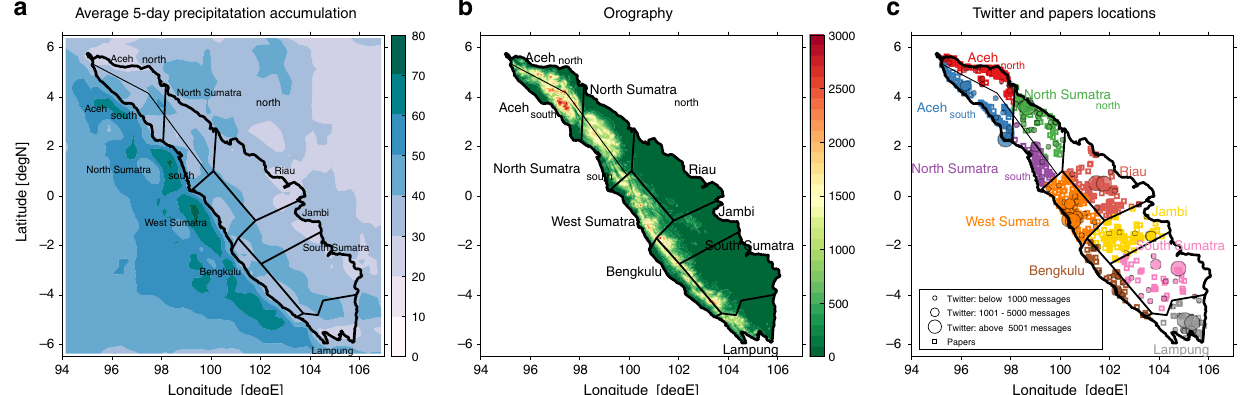
Fig. 1 Environmental conditions and fl ood data availability in Sumatra. Map of Sumatra with division into provinces. The two most northern provinces (Aceh and North Sumatra) are additionally divided at the mountain range into a northern and southern part. a Average 5-day precipitation accumulation [mm] based on TRMM satellite-derived estimates. b Sumatra's topography [m]. c The spatial distribution of fl ood data sources from the Papers (squares) and Twitter (circles) in all of Sumatra's provinces between 2014 and 2018. Size of a circle represents the number of records at individual location. Each color shows one